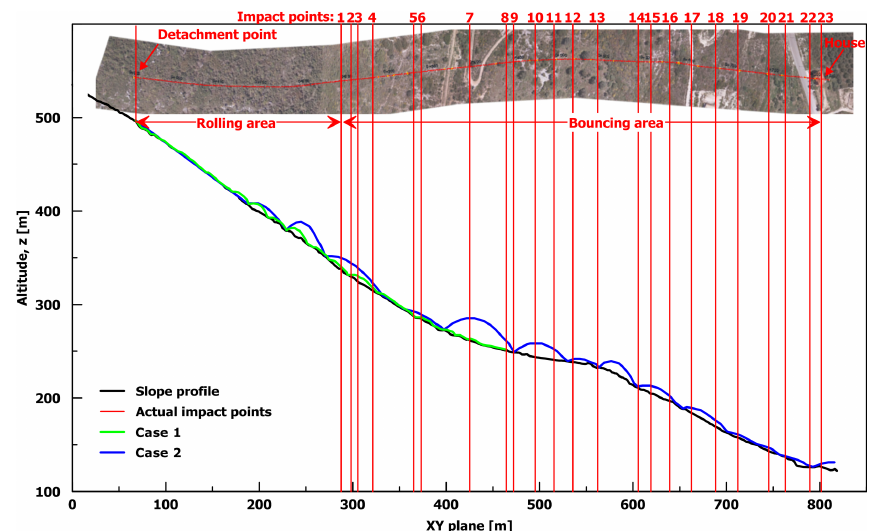
Figure 8. Plan view and cross section along the block’s path (units in m); 2-D rockfall trajectory analysis results are plotted with the green and blue line.